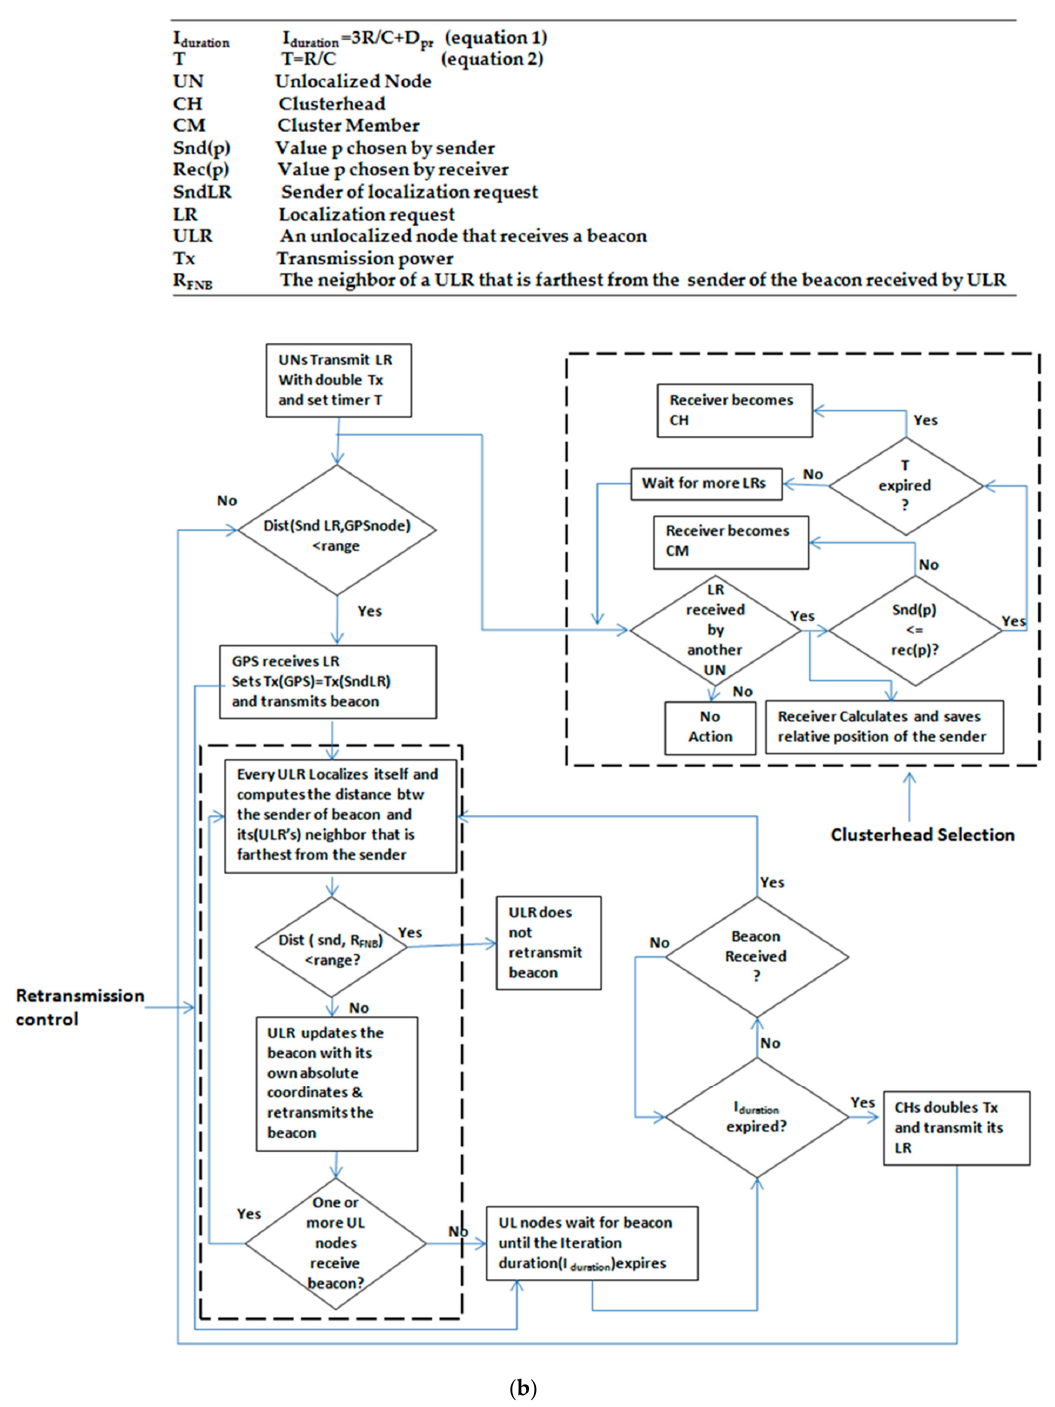
Figure 5. ( a ) Flow chart Phase 1; ( b ) Flow chart Phase 2.